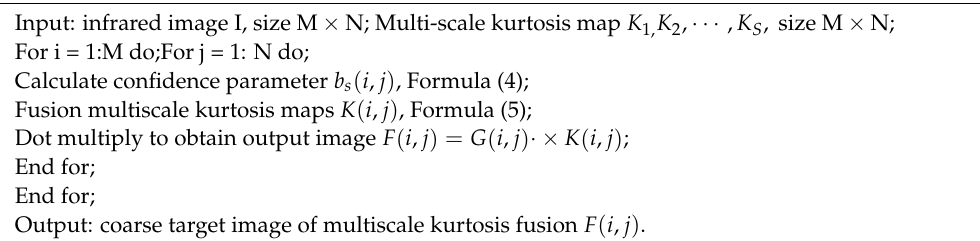
Algorithm 2 Multiscale Kurtosis Map Fusion